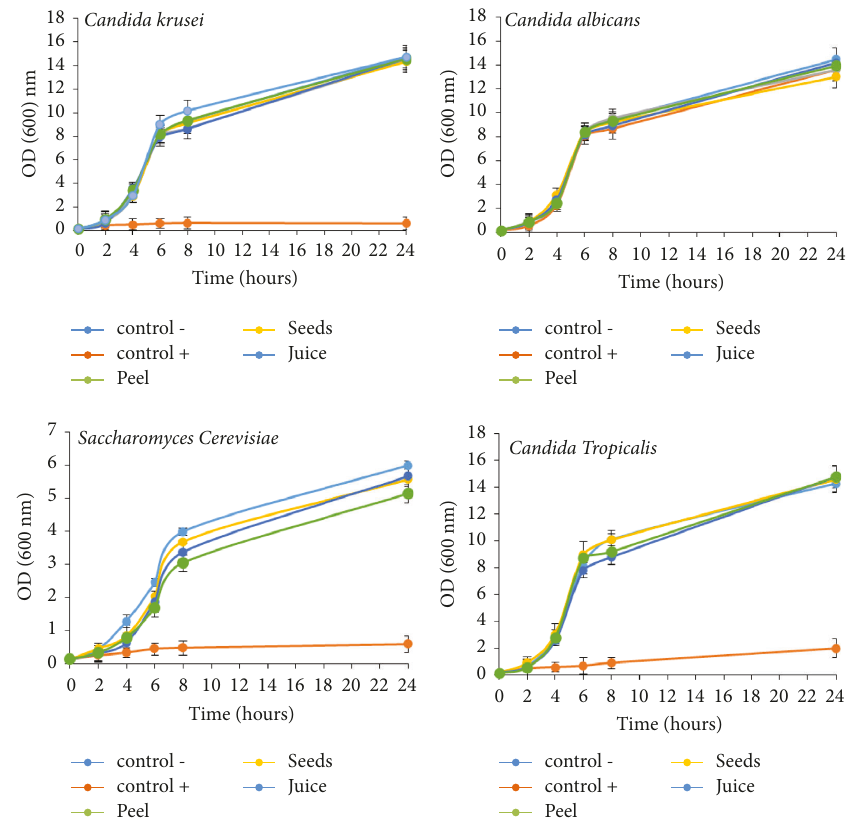
Figure 4: Antifungal activity of O. dillenii fruit ethanolic extracts (peel, seeds and juice). Cells were cultured in the presence or absence of 1mg/mL of each extract and the growth rate of cells was monitored every 2h by measuring the OD 600 , as described in the materials and methods section. The residual extract of Fredolia aretioides was used as a positive control due to its recognized antifungal activity [32] and DMSO was used as a negative control. All experiments were carried out in triplicate. Error bars are shown; when they are not visible, they are shown smaller than the data symbols. Table 6: Antibacterial activity of ethanolic extracts of O. dillenii on Listeria monocytogenes (a), Staphylococcus aureus (b), Salmonella braenderup, (c) and Escherichia coli (d).